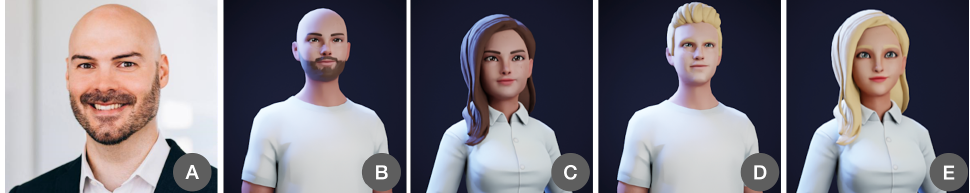
Figure 1. We investigate how different avatar embodiment influences user emotions in VR. We used the participant’s photograph ( A ), to generate four types of embodiment: ( B ) personalized, same- gender avatar based on ( A , C ) personalized opposite-gender avatar based on ( A , D ) non-personalized, same-gender avatar, and ( E ) non-personalized opposite-gender